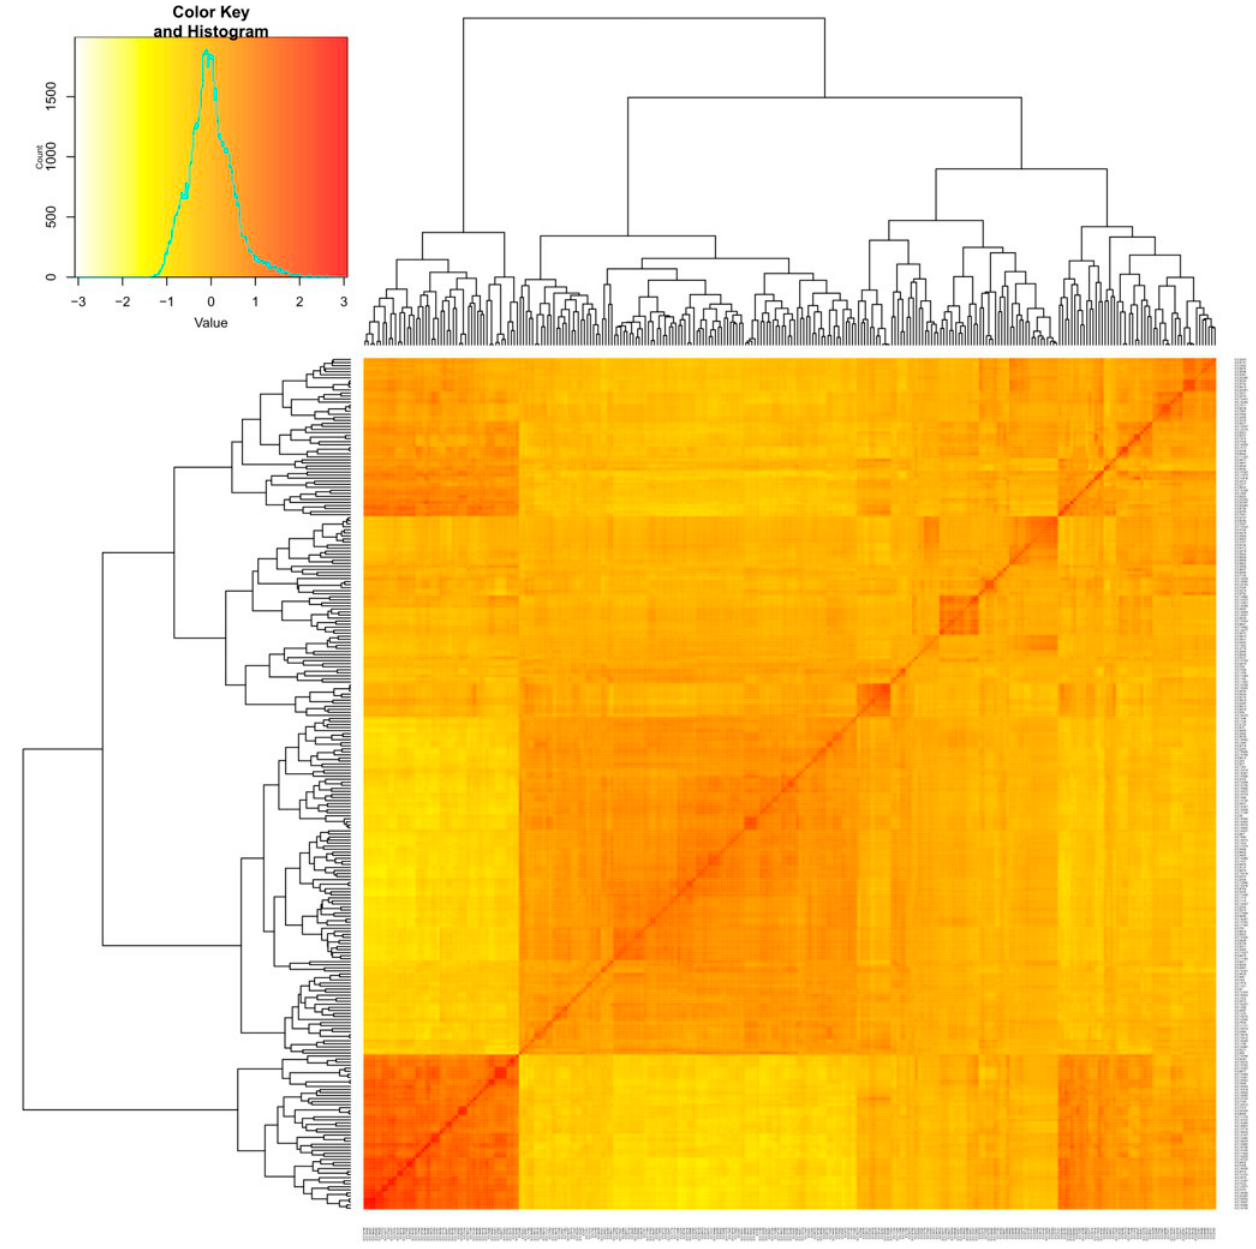
Figure 4. Heat map plot of kinship matrix using average linkage clustering based on SNP markers depicts the existence of three different groups among chickpea accessions.